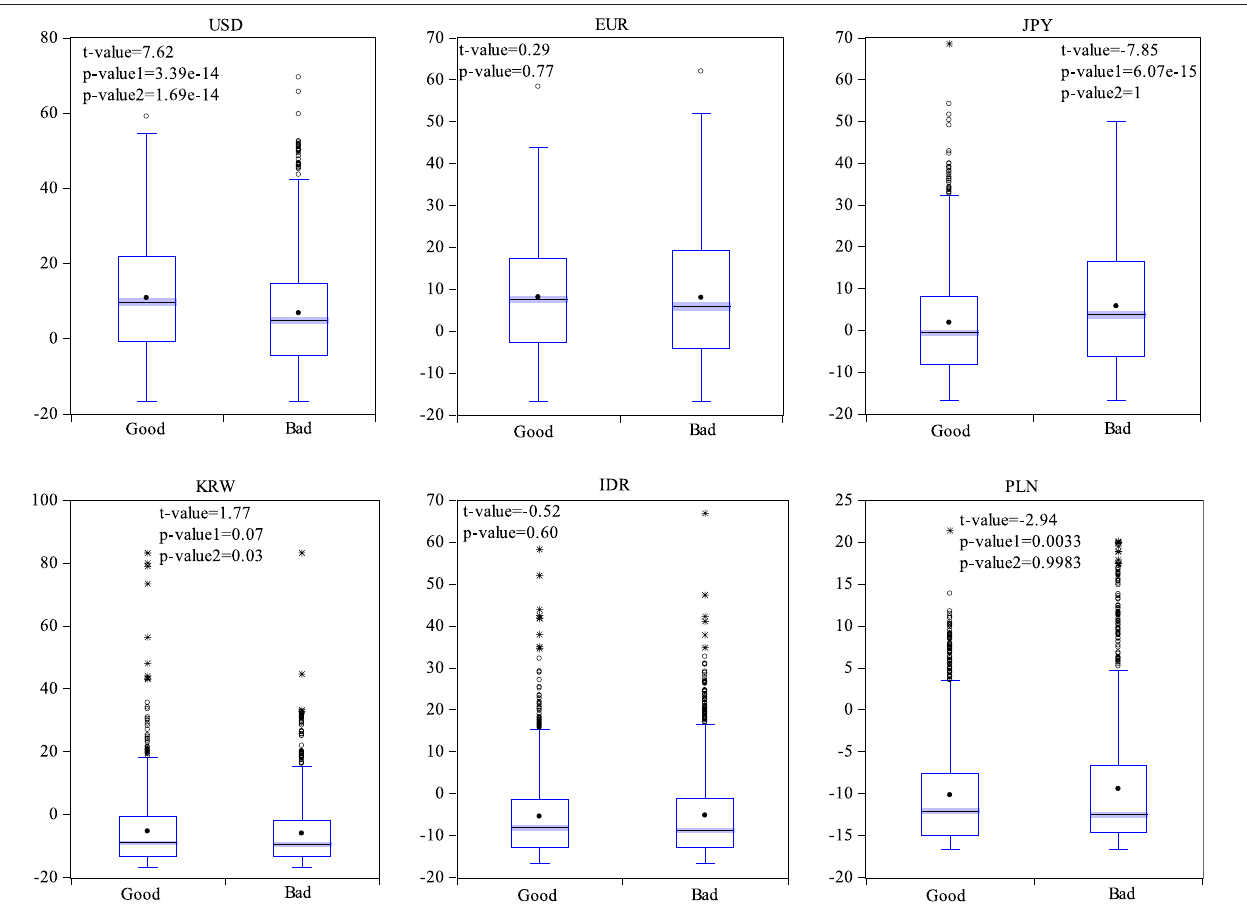
FIGURE 6 | Test results of net spillovers between good and bad volatilities ( p < 0.05). Note: I. The boxplot show the dynamic net spillovers of good and bad volatilities among different Bitcoin markets. II. The t-value is the value of t-statistics. The p -value1 is the p -value of test (3). The p -value2 is the p -value of test (4). If the p -value1 is larger than 0.05, it is replaced by p -value. III: Test (3): TAM 2 i (cid:1) 0 . vs TAM 2 i ≠ 0 . Test (4): TAM 2 i < 0 . vs. TAM 2 i > 0